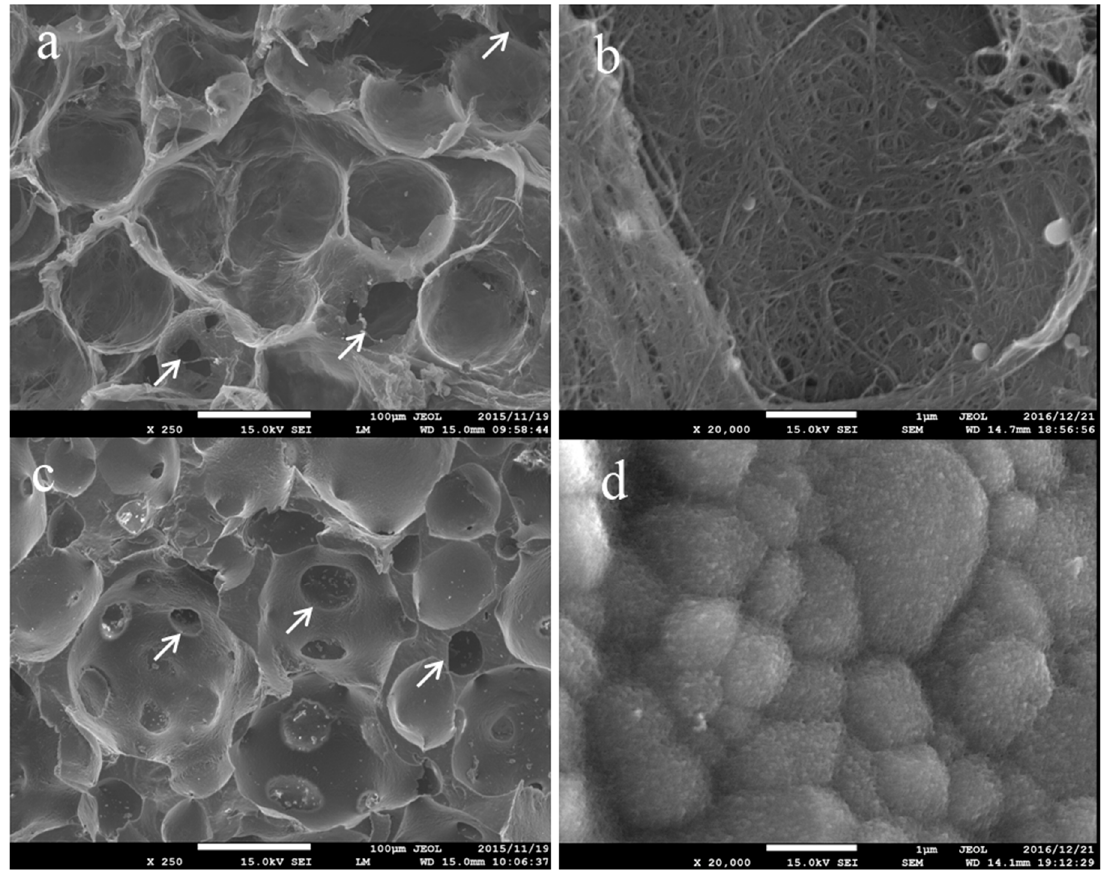
Figure 1. Scanning electron microscope (SEM) image of ( a , b ) carbon nanotube (CNT) porous block (CNTp) and ( c , d ) interconnected porous HA ceramic (IP-CHA). Original magnification is 250 × for ( a , c ) and 20,000 × for ( b , d ). White arrows: interporous connections.